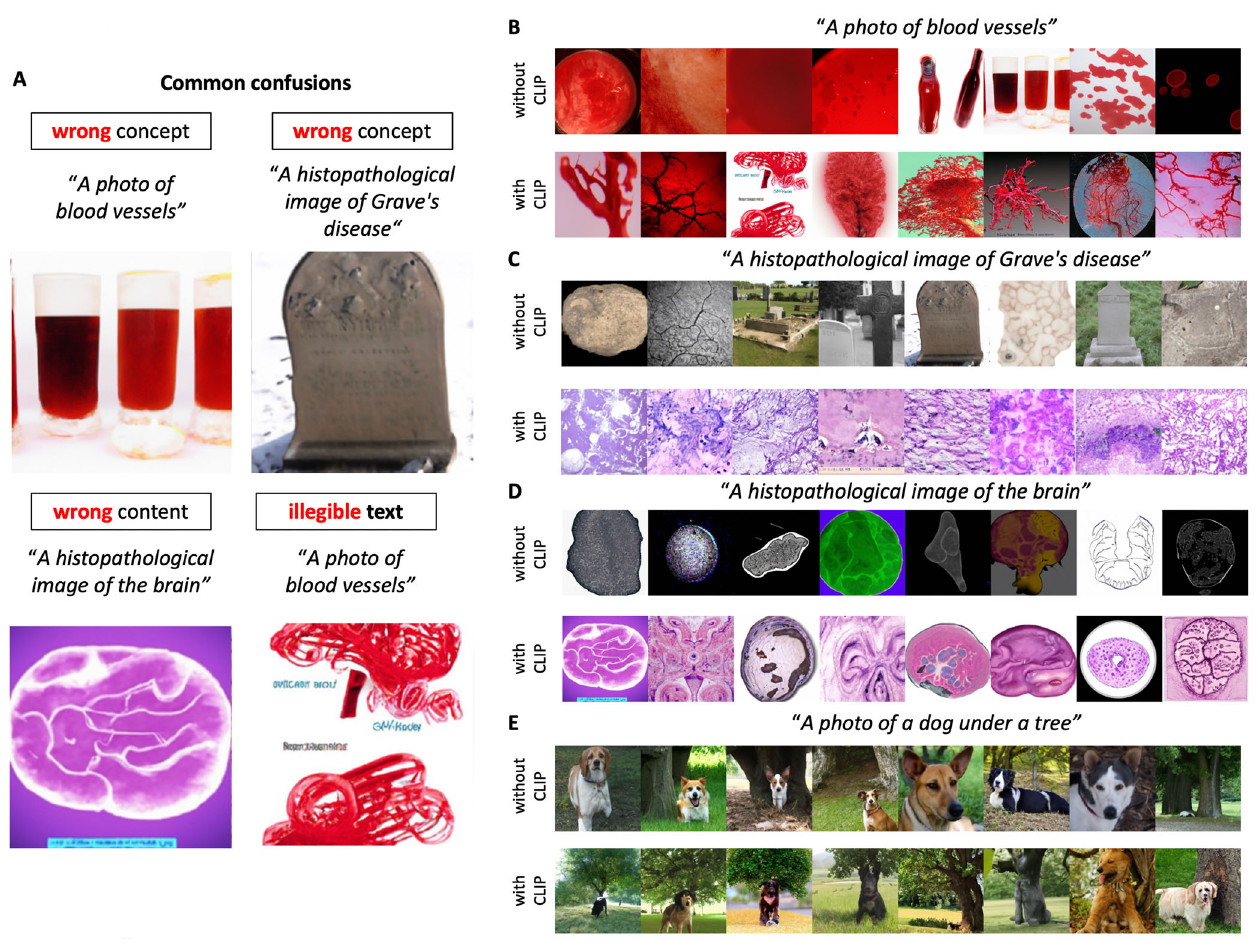
Fig. 2 Common confusions of the model. A Example images of common confusions observed in our study, B – E Generated images without and with CLIP guidance for four text prompts. For each prompt, eight random images are shown and these images are not